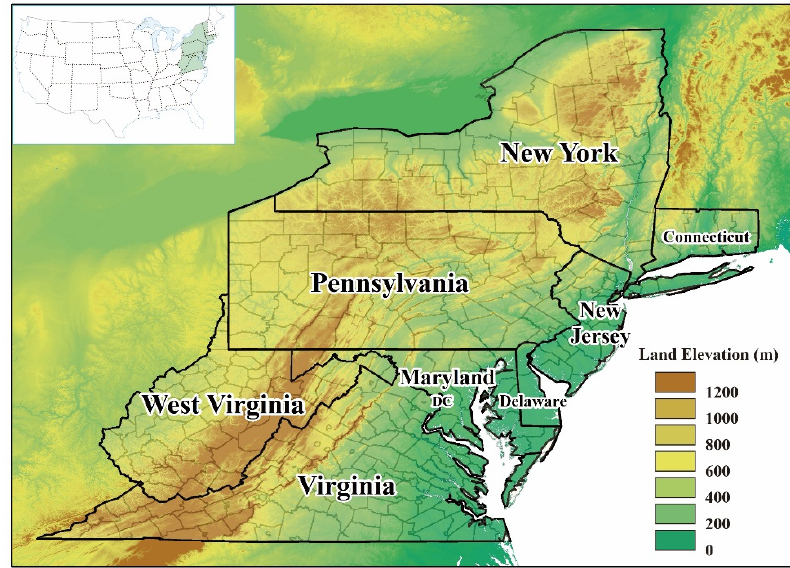
Figure 2. Location map of study area with elevation.